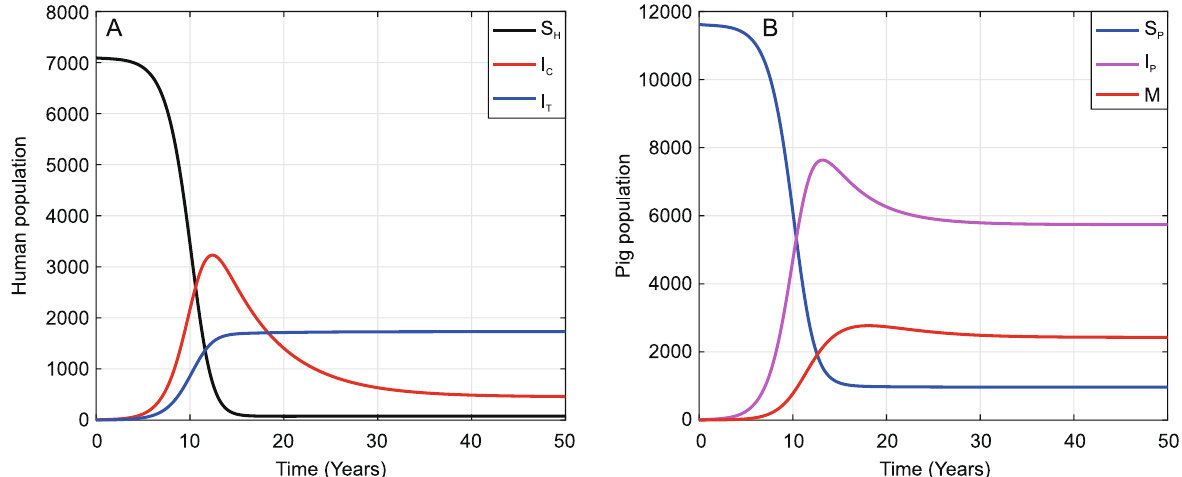
Fig. 3 Dynamics of Taenia solium taeniasis and cysticercosis in human and pig population. A . Human population; B . Pig population